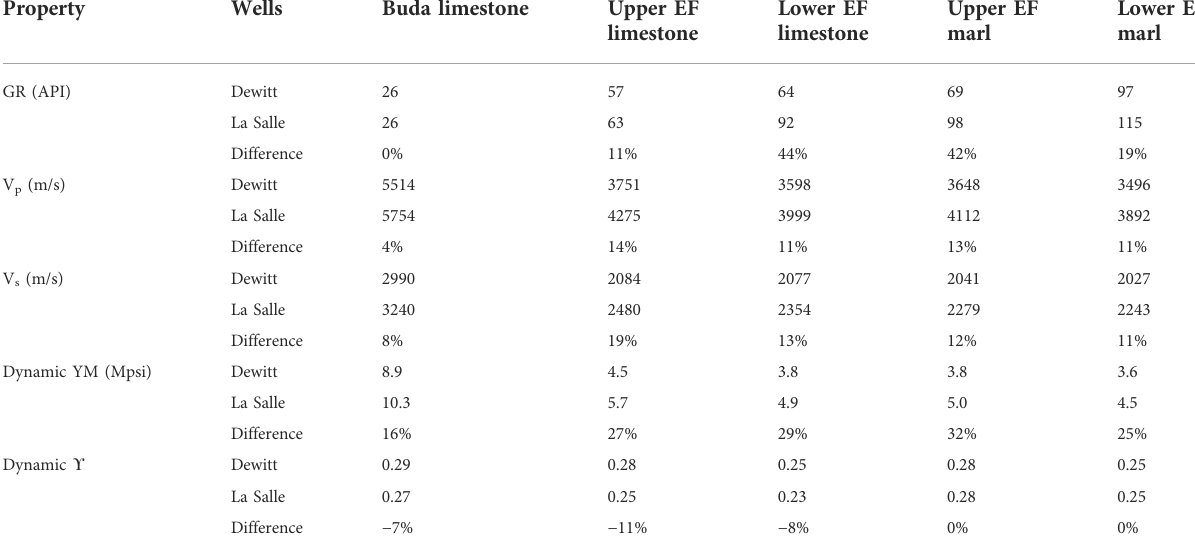
TABLE 6 Comparison of elastic parameters in different layers of two Eagle Ford